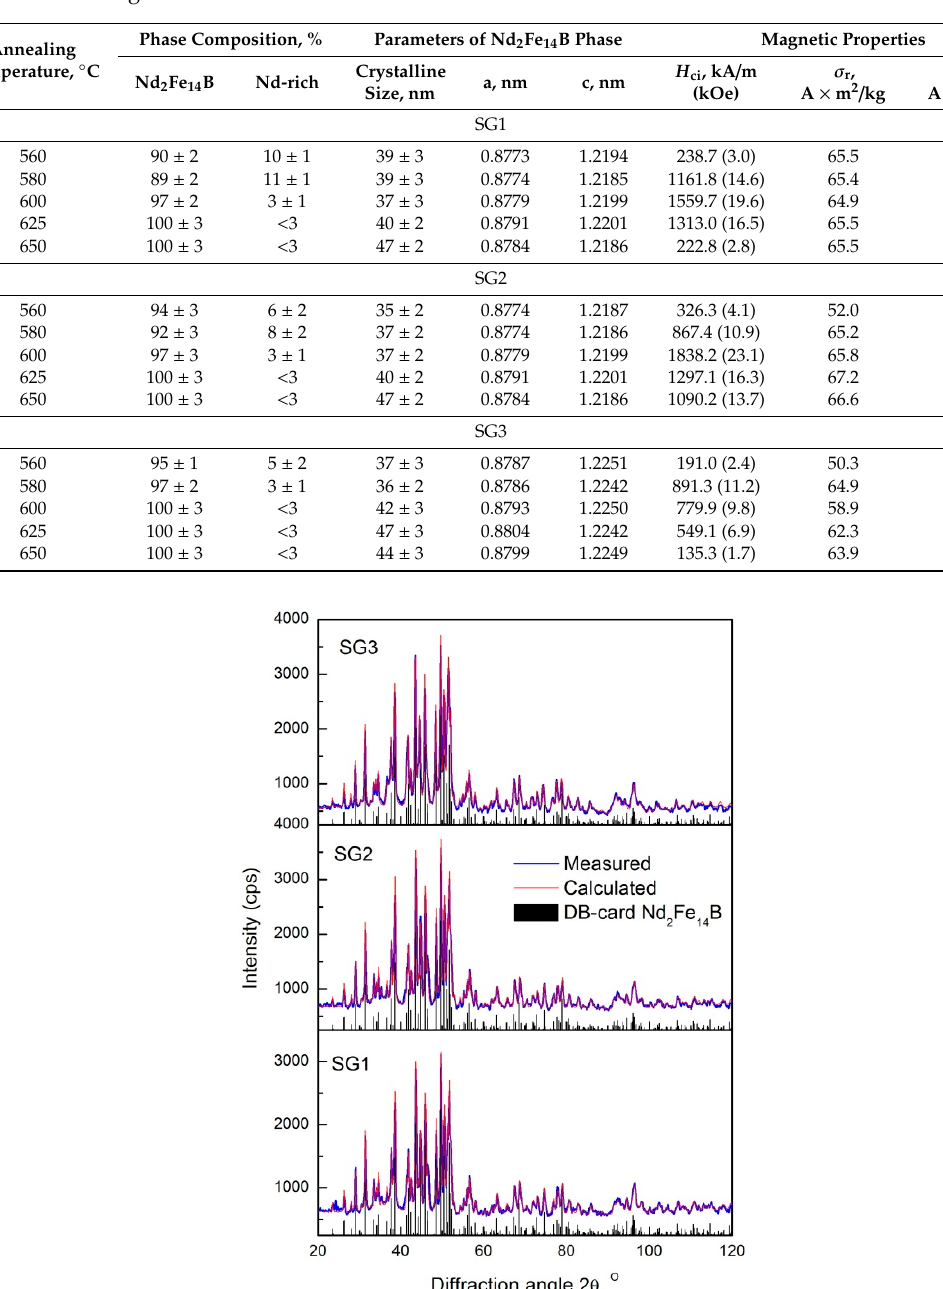
Table 2. Results of the quantitative phase analysis and magnetic properties of the samples after annealing.